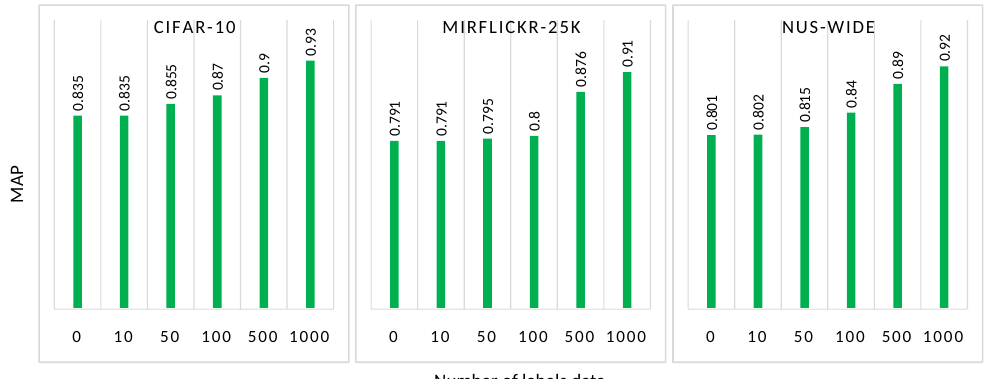
Figure 7. The figure represents the increase of MAP by mixing a small portion of labeled/ground data while training AutoRet. The three graphs exhibit the benchmark conducted in CIFAR-10, MIRFlickr-25K, and NUS-WIDE,